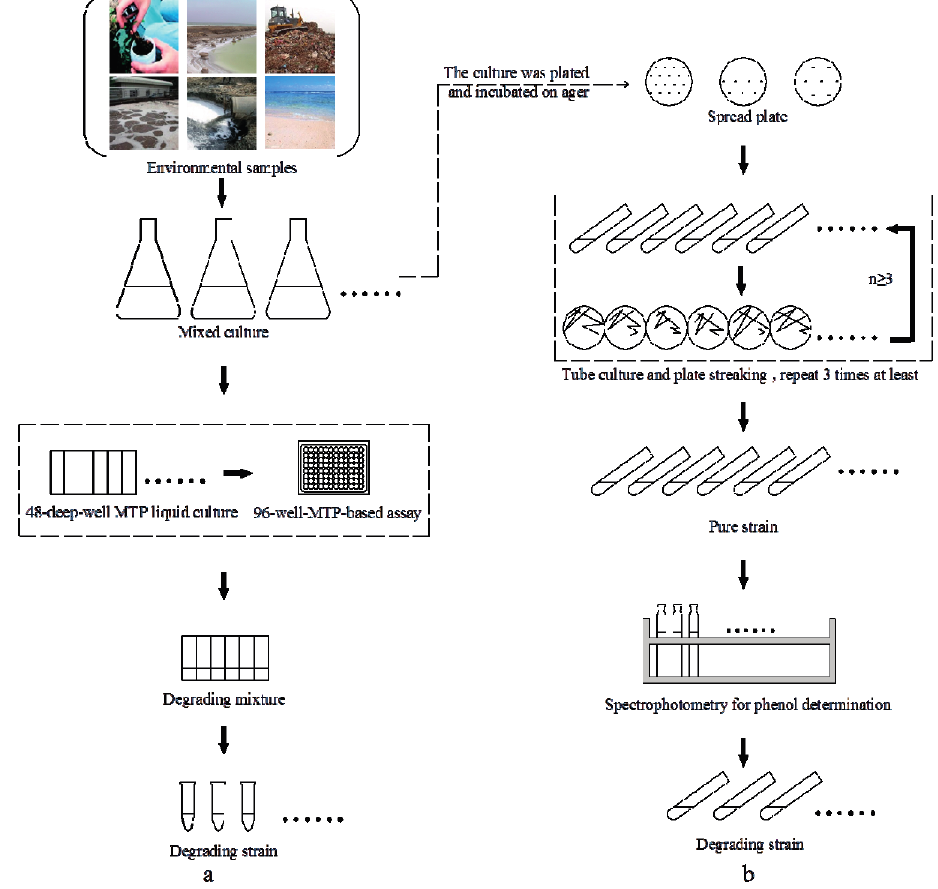
Figure 1. An integrated procedure for high-throughput screening. ( a ) High-throughput screening for the degrading strain; ( b ) Traditional method for the degrading